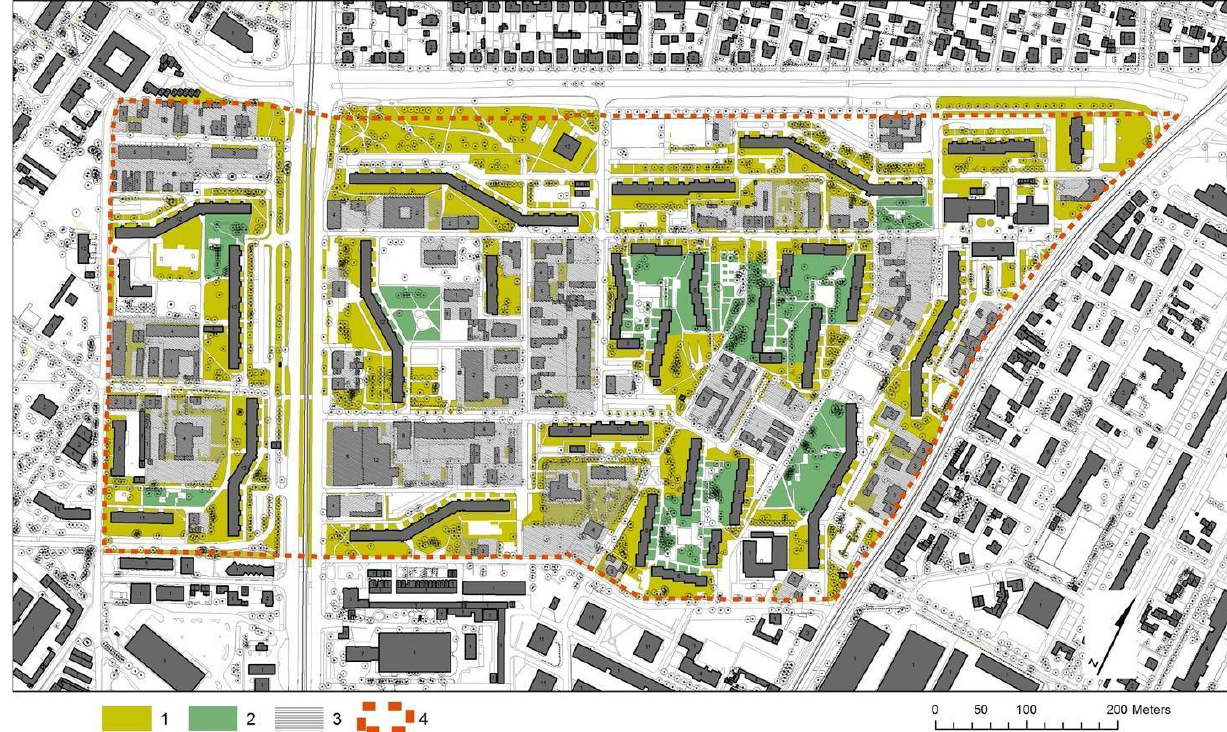
Figure 2. General layout of the Zgierska‐Stefana housing estate with an analysis of the types of open green spaces. Notes: (1) Greenery isolating and accompanying buildings; (2) recreational spaces; (3) historical parcellation; (4) site